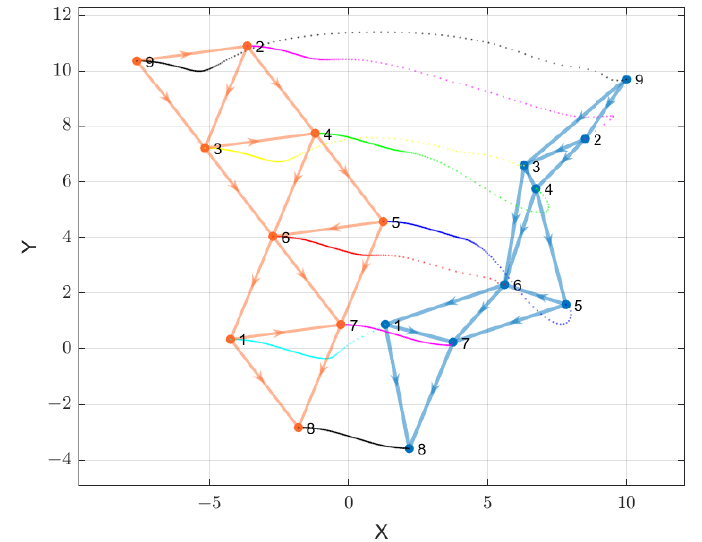
Figure 6. Formation evolution of 9 robots. Blue graph on the right side shows the initial state of the robot team. On the left side, the robot team is stabilized to the desired formation colored in orange. The intermediate lines represent robot’s trajectories.